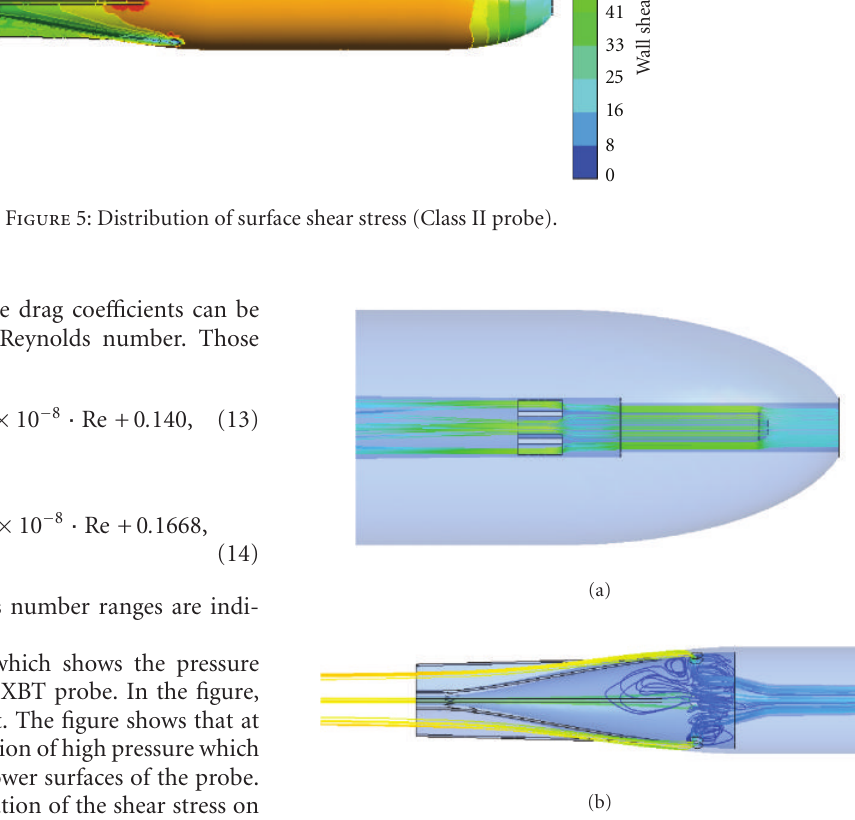
be seen that the flow is channeled in the streamwise direction as it enters the center channel of the probe. The fluid in this channel washes over the temperature probe before passing through the body and emptying into a downstream